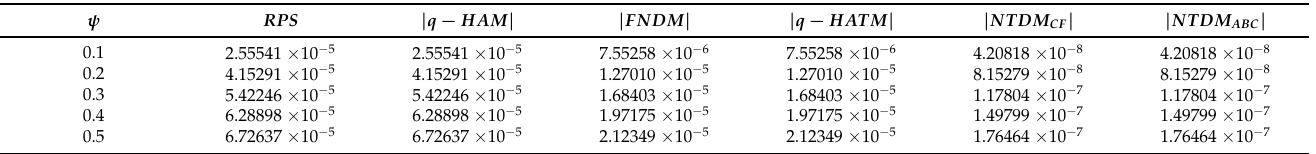
Table 4. Error comparison among RPS , q − HAM , FNDM , q − HATM , NDM CF and NDM ABC for problem 2 at β =